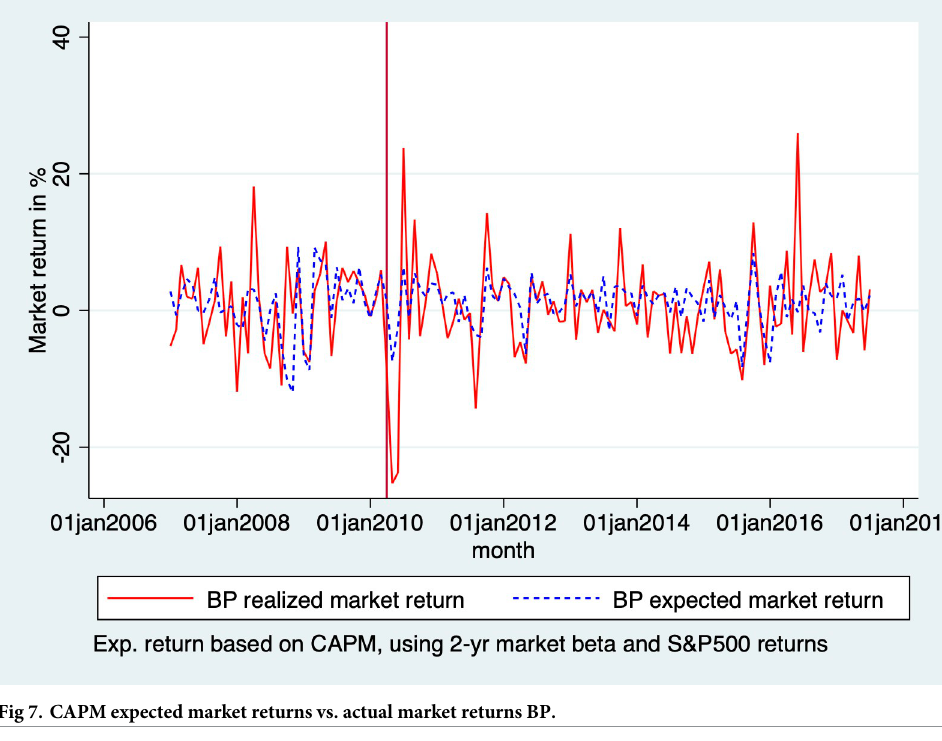
Fig 7. CAPM expected market returns vs. actual market returns BP.